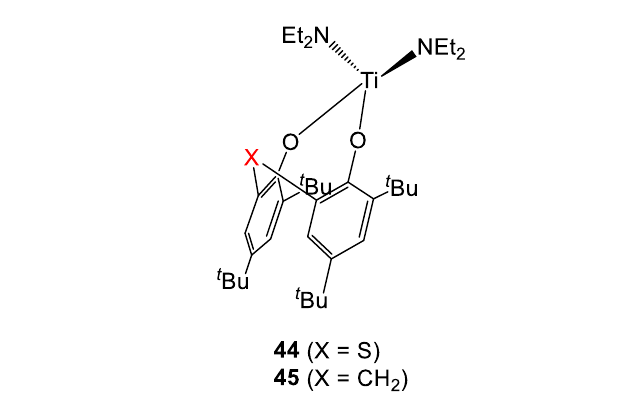
Figure 12. Diethylamido-derivatives of S- and CH 2 -bridged diphenolate titanium complexes [25].